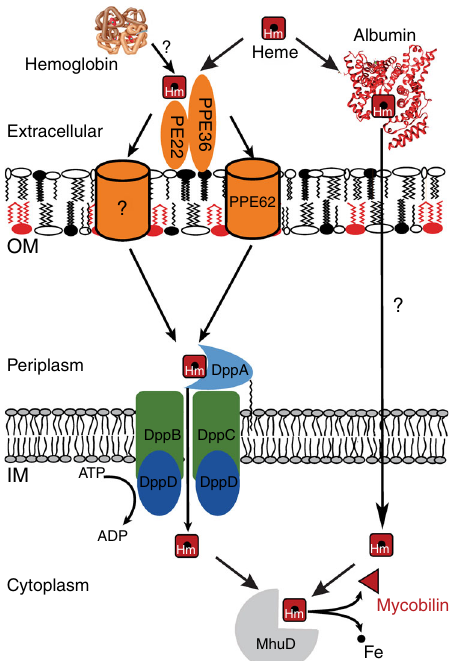
Fig. 9 Model of heme acquisition by M. tuberculosis . PPE36/PE22 and PPE62 are cell surface-accessible proteins of Mtb that bind heme (red octagon) and are anchored in the outer membrane (OM) 15 . After uptake across the OM, heme is transferred to the periplasmic lipoprotein DppA, possibly with the help of the periplasmic heme-binding protein Rv0265c. DppA probably delivers heme to the DppBCD transporter for uptake across the inner membrane (IM) as shown for other substrate-binding proteins of ABC transporters 75,76 . PPE37, which was recently shown to be essential for heme utilization in Mtb Erdman, is not depicted since its localization is unknown. Cytoplasmic heme is degraded to mycobilin by the oxygenase MhuD thereby releasing iron (black dot). Heme is degraded in the cytoplasm by the involved in heme ef fl ux, are not depicted since it has not been experimentally validated. The fact that PPE36/PE22, PPE62, and the Dpp transporter are required for heme and hemoglobin utilization by Mtb indicates that these pathways converge at the cell surface of Mtb. Our study indicates that there is an alternate heme uptake pathway mediated by albumin, whose components are not known. However, the mechanism by which heme is released from hemoglobin is unknown. Figure adapted from ref.